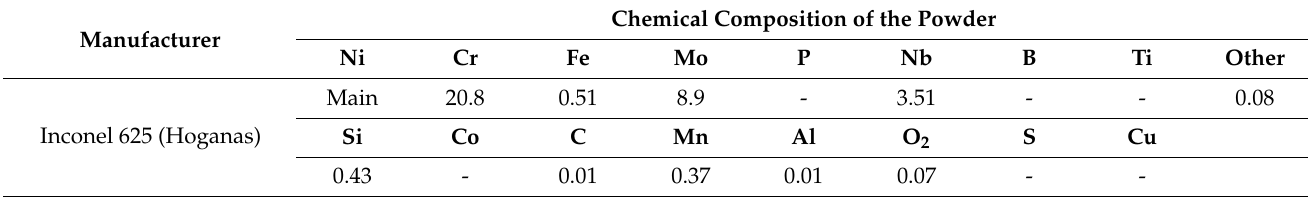
Table 1. Chemical composition of the Inconel 625 powder.